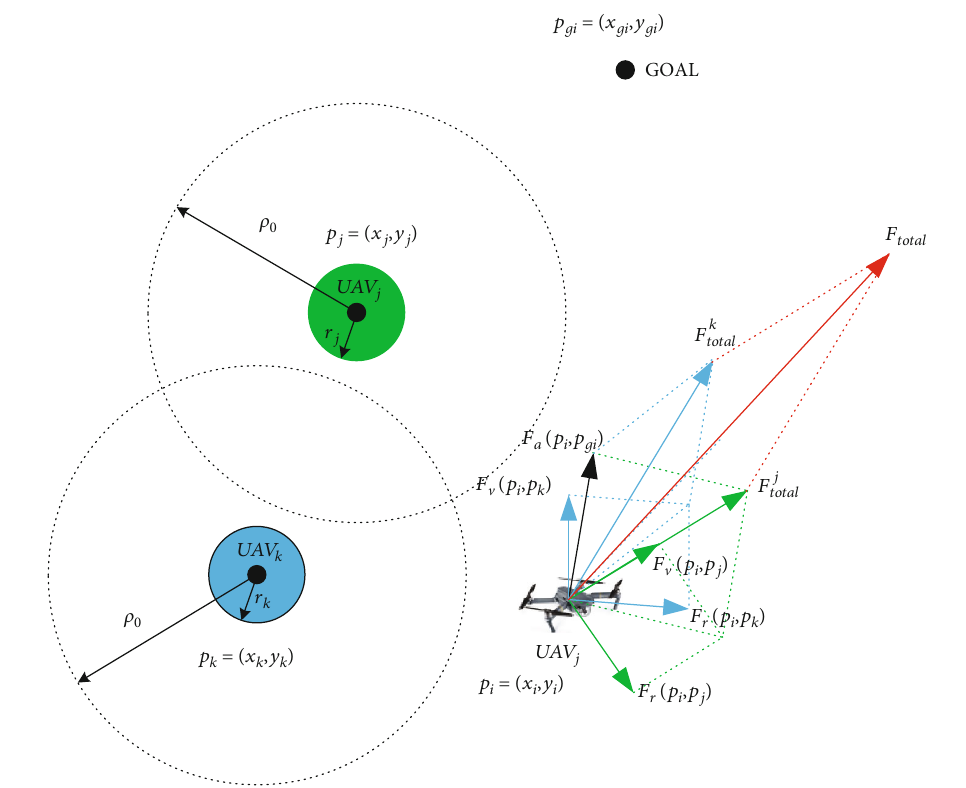
Figure 2: Schematic diagram of the arti fi cial potential fi eld Table 1: UAV con fl ict resolution strategy coding diagram. UAV 1